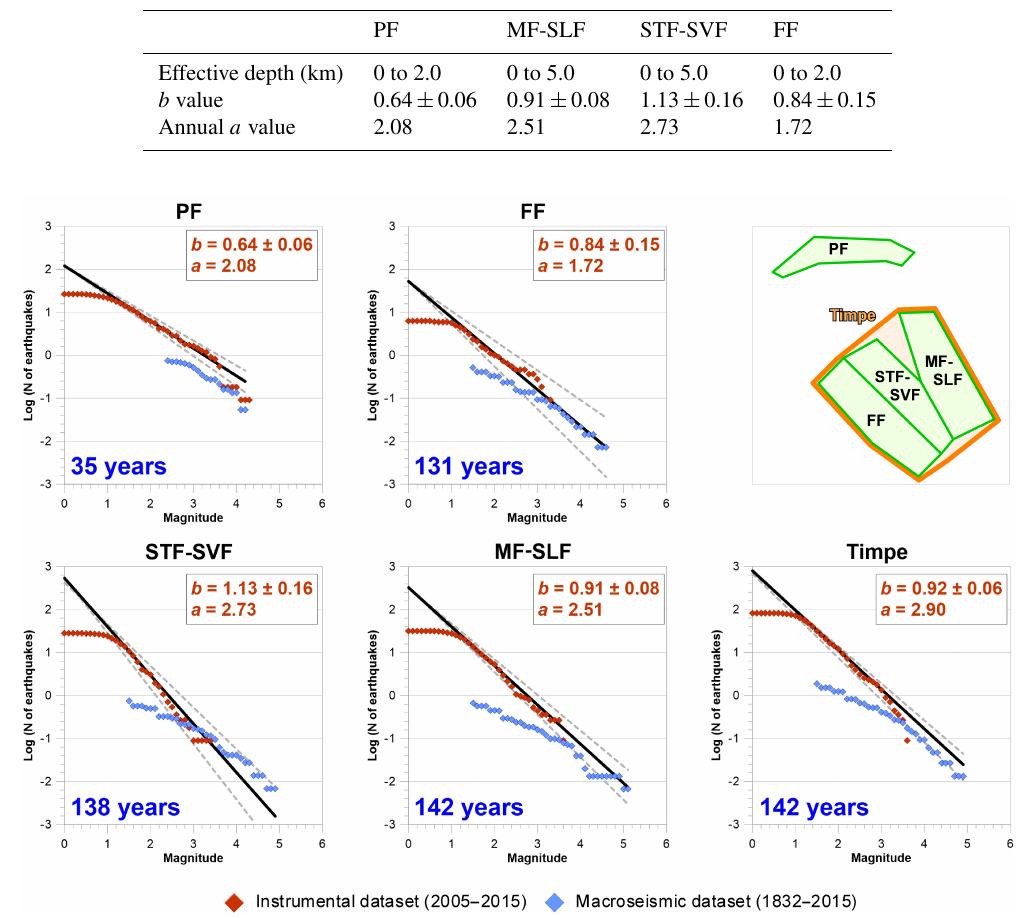
Figure 6. Frequency magnitude distribution for each SZ. Red dots refer to the instrumental dataset, blue dots to the macroseismic one; dotted lines indicate uncertainties concerning the GR relationship (black line). b and a values are obtained from the instrumental earthquake dataset. Years indicate the actual time window ( T last − T first ) of the events in each sub-catalogue of the historical dataset. Data are normalized to 1 year. Abbreviations as in Fig.